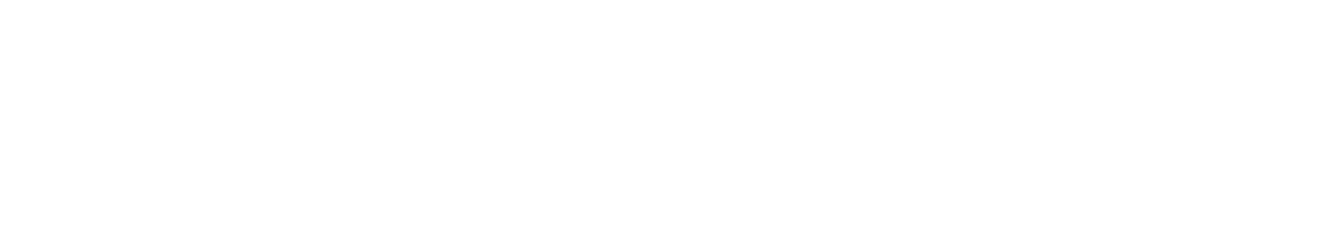
FIGURE 2 A schematic of the APM cavity, defining the model fields ax, a., bx, and